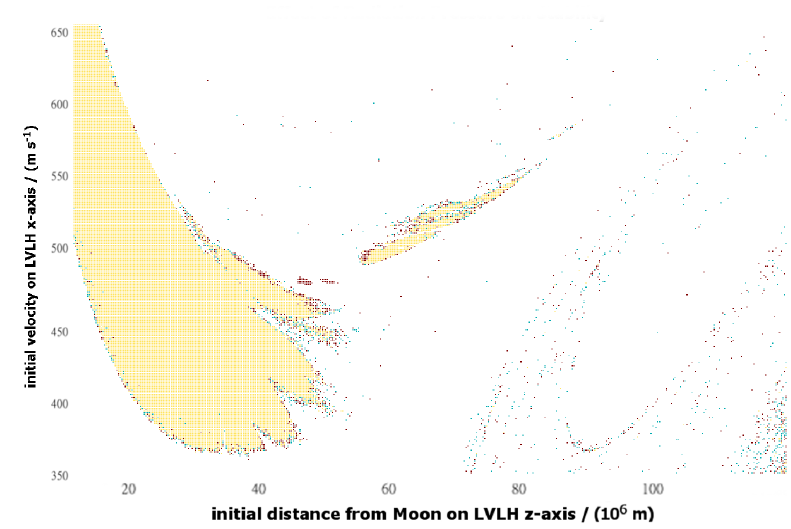
Figure 20. Graphical representation of the effect of radiation pressure on the stability of DROs. The horizontal axis represents the initial position (m), measured along the LVLH z -axis; the vertical axis represents the initial velocity (m · s − 1 ), directed along the LVLH x -axis. The color axis is interpreted as: Yellow/light shading—initial conditions that produce 30-year-stable trajectories without radiation pressure and 5-year-stable trajectories with radiation pressure; Blue/medium shading—initial conditions that produce 5-year-stable trajectories with radiation pressure but did not produce 30-year-stable trajectories in the non-radiation pressure data set; Red/dark shading—initial conditions that produce 30-year-stable trajectories without radiation pressure but fail to do so with radiation